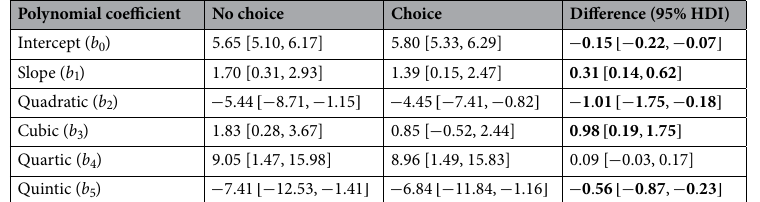
n ) 3 55 . Differences where t = −